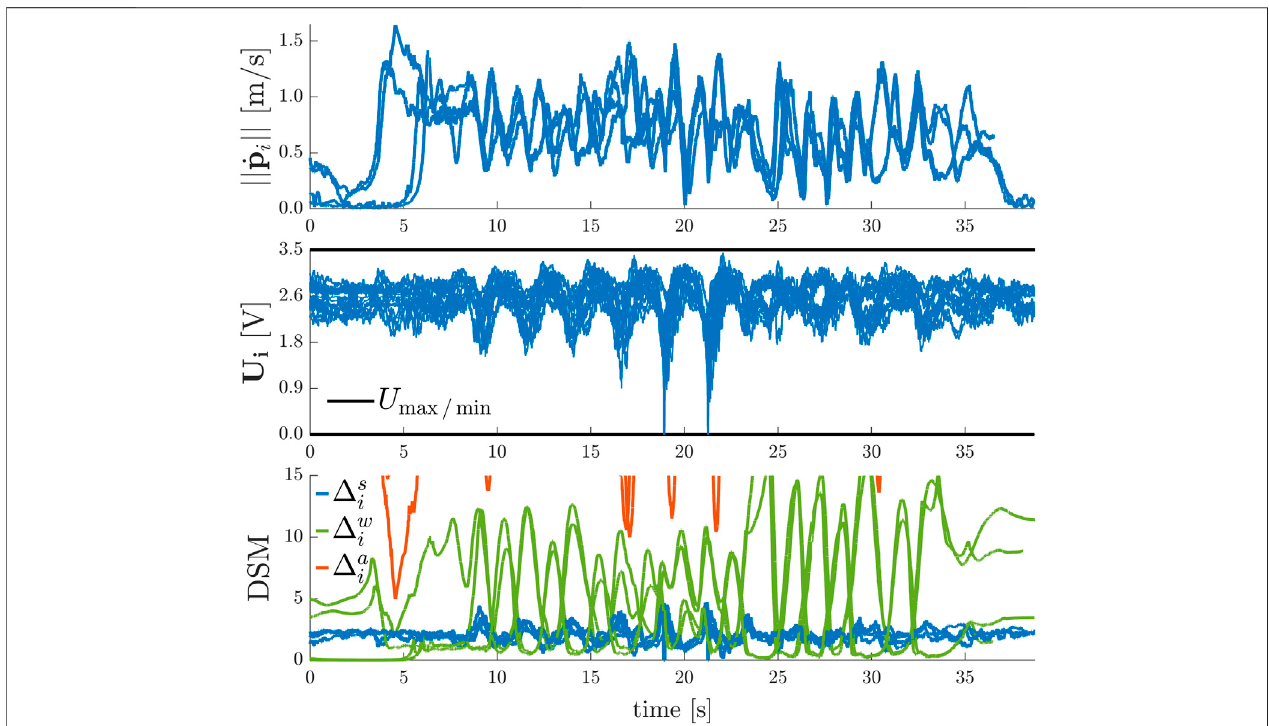
FIGURE 11 | Results of the Human-Swarm Teleoperation Experiment in a Con fi ned Environment − The D-ERG ensures the safe coordination of the quadrotor team formation. During the short periods where the actuator inputs come very close to their upper and lower limits (around t (cid:2) 20 . 0s), the DSM decreases rapidly such that the applied reference is kept almost constant. Note that the steady-state motor voltages during hovering after t > 37 . 0s vary in a range of 2 . 1V to 3 . 0 V. This is caused by variabilityinmodelparameters(e.g.batterydisplacementsfromtheMAV ’ scenterofmass,differentmotor-propellerconstants)andshowstherobustnessoftheoverall approach to model